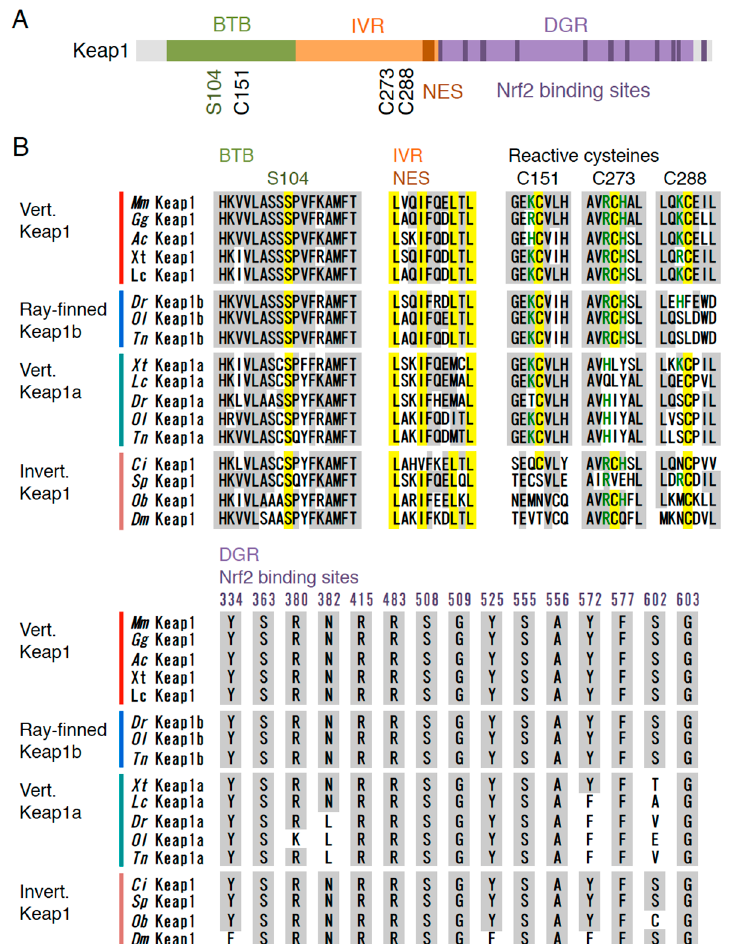
Figure 5. A comparison of Keap1 proteins: ( A ) domain structures of Keap1; and ( B ) amino acid sequences of Keap1 proteins from mouse ( Mm ), chicken ( Gg ), anole lizard ( Ac ), clawed frog ( Xt ), coelacanth ( Lc ), zebrafish ( Dr ), medaka ( Ol ), green spotted puffer ( Tn ), ascidian ( Ci ), sea urchin ( Sp ), octopus ( Ob ) and fruit fly ( Dm ). The amino acids identical to mouse Nrf2 are shaded in gray. The serine residues essential for homodimer formation in the BTB domain, NES consensus sequence in the IVR domain and three reactive cysteine residues are shaded in yellow.